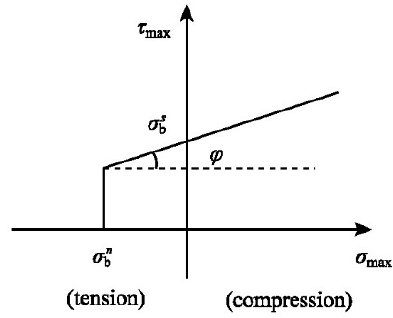
( b ) Figure 2. Bonding failure model of particle element. ( a ) Tensile failure; ( b ) shear failure. The tensile failure strength